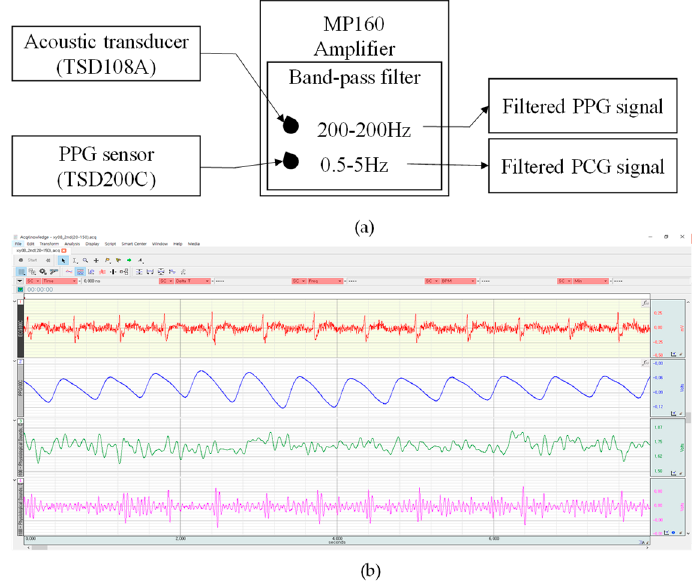
Figure 4. Noise reduction: ( a ) block diagram for filtering ( b ) Example of data obtained through MP160 (BIOPAC System, Inc., Goleta, CA, USA) (Subject ID: XY08). The red, blue, green, and magenta solid lines illustrate the ECG, PPG, raw PCG, and filtered PCG signals (bandpass filter with 20–150 Hz), respectively.